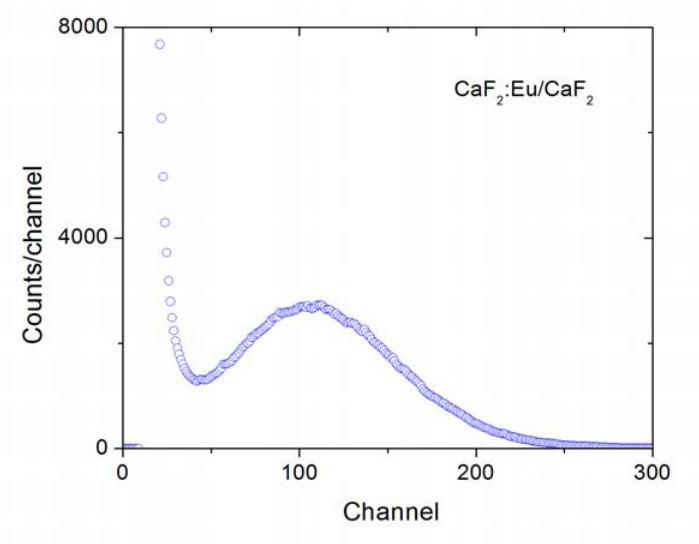
Figure 7. Pulse height distribution measurement of CaF excitation of 241 Am